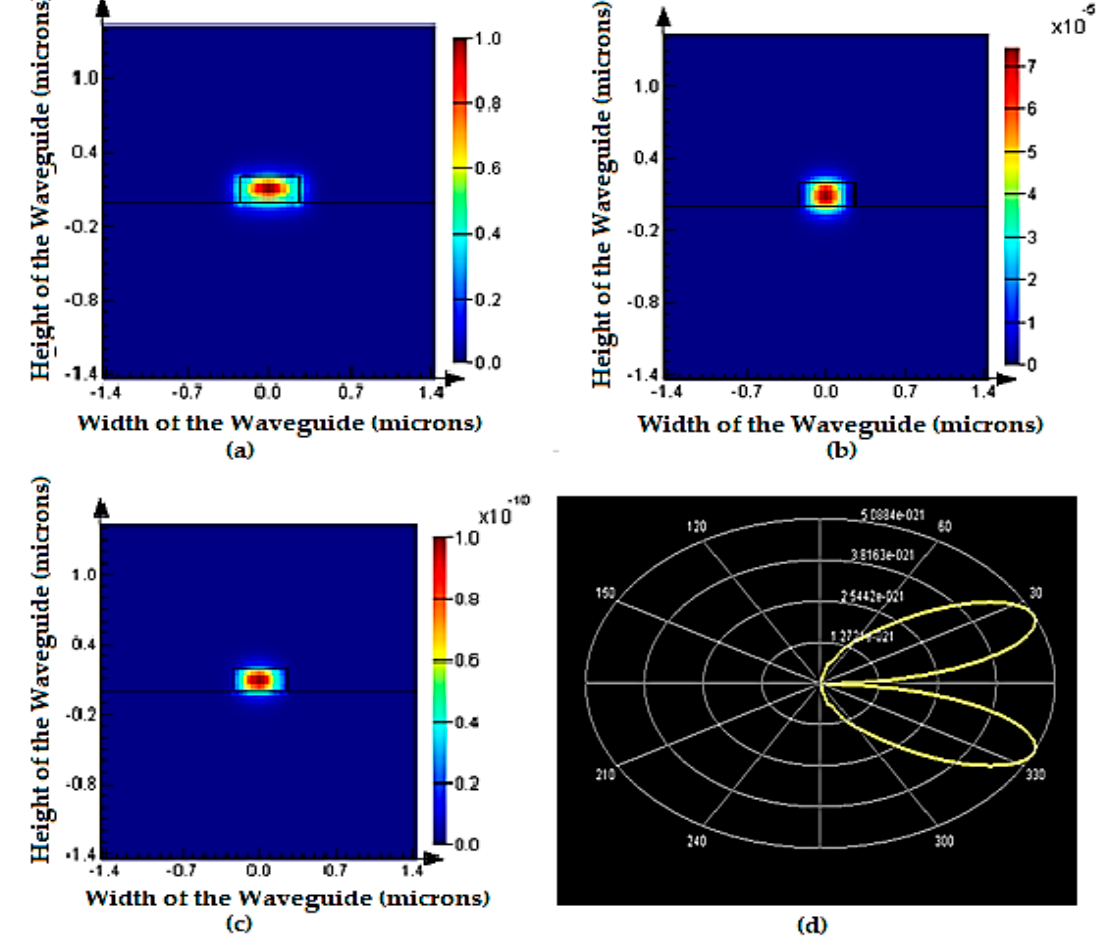
Figure 7. Mode confinement plots at 1550 nm: ( a ) electric field intensity; ( b ) magnetic field intensity; ( c ) energy distribution; and ( d ) polar plot of Poynting vector.